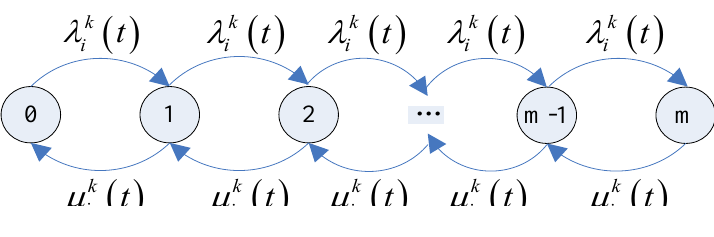
Figure 4. The flow chart of the stable state